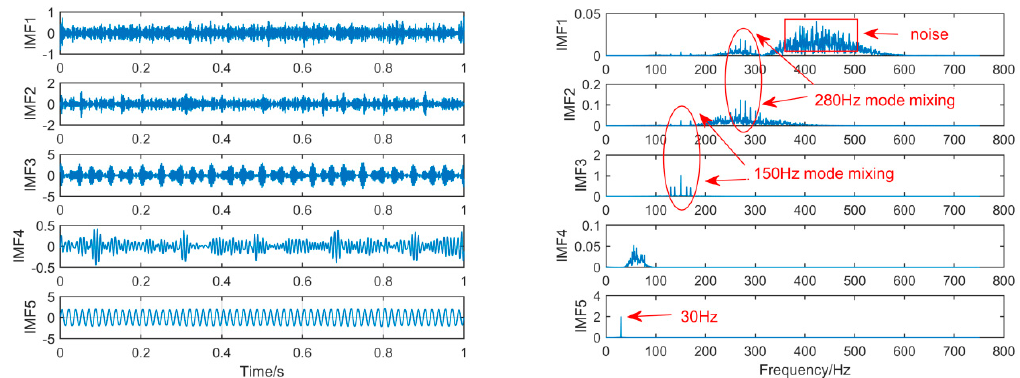
Figure 8. The spectrum of IMFs after SSD and its corresponding spectrum.